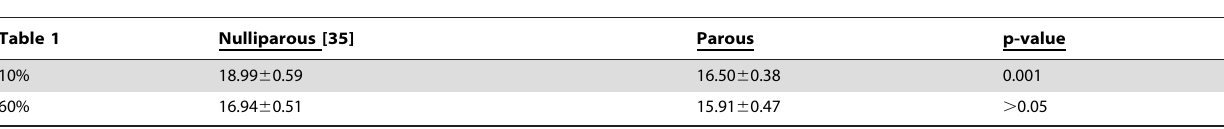
Table 1. Tumor latency in C3(1)-T Ag nulliparous and parous mice.